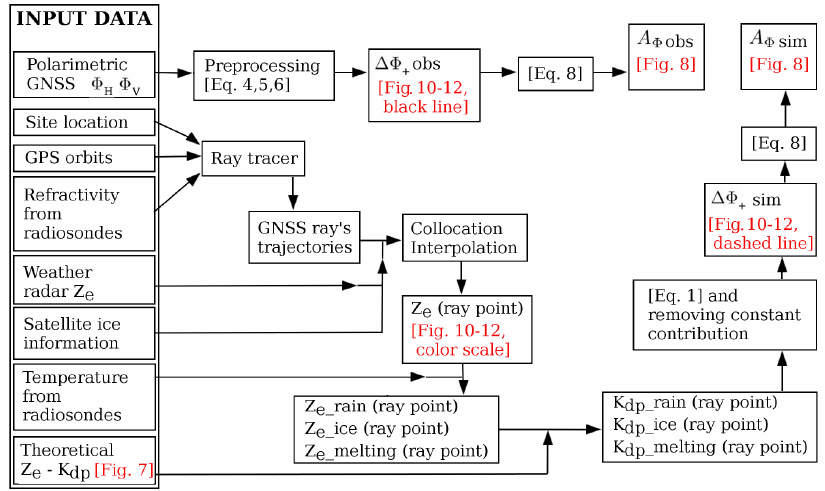
Figure 9. Block diagram showing all the data analysis and modelling process. All steps from the data acquisition to the final results are shown.